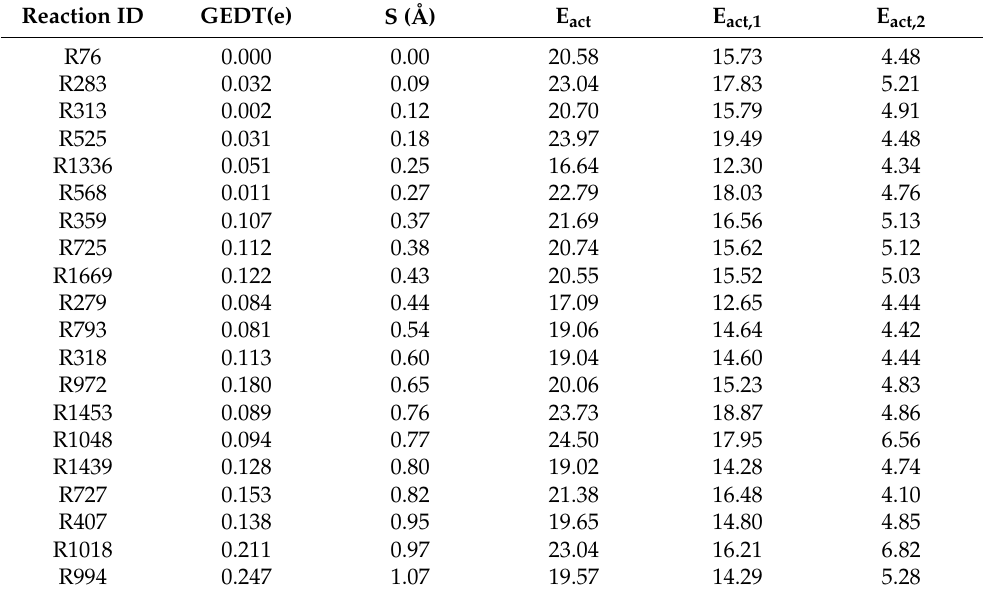
Table 1. Activation energy decomposition and its relationship with the polarity and synchronicity for a representative set of twenty reaction features. E act , E act,1 and E act,2 expressed in kcal/mol. Reaction